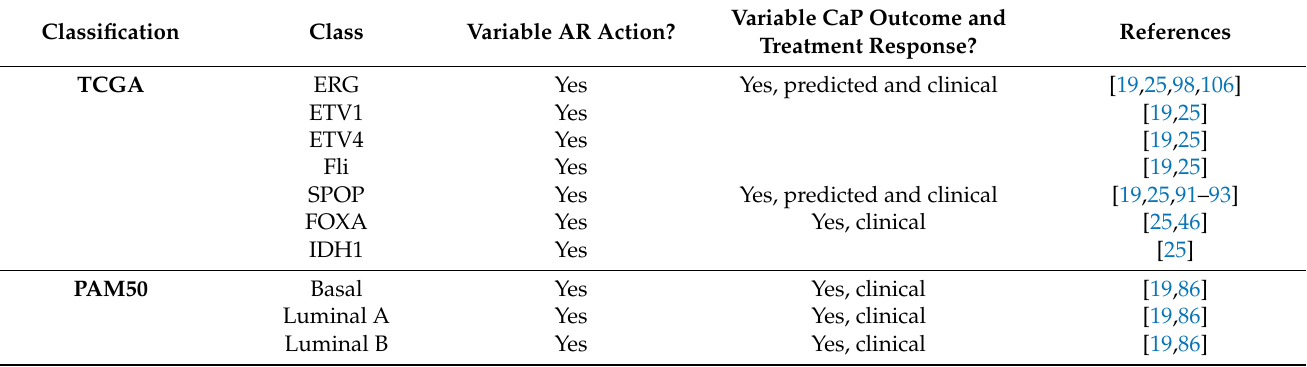
Table 1. Somatic alterations that have been linked to differential AR action may be associated with diverse responses to CaP